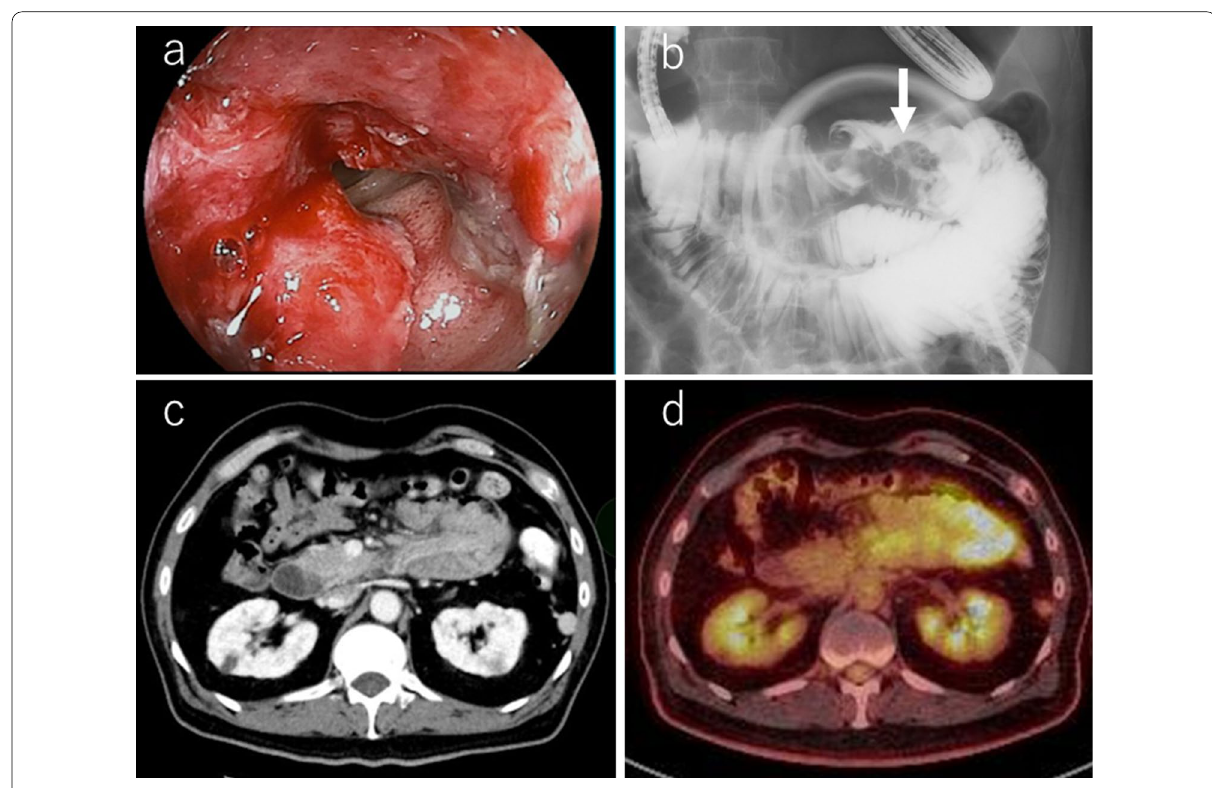
Fig. 1 Preoperative imaging findings. a Endoscopic findings: enteroscopy revealed an easily hemorrhagic tumor in the jejunum. b Findings of the small bowel series using meglumine sodium amidotrizoate: a tumor (white arrow) was found in the jejunum at the angle of Treitz. c Contrast-enhanced computed tomography findings: The tumor with intussusception appeared as a reniform shape (pseudokidney sign) longitudinally and demonstrated multilayered concentric rings of mass (target sign) transversely. A tumor with intussusception and regional lymph node swelling was located at the angle of Treitz. d Findings of the fluorodeoxyglucose positron emission tomography: this tumor had marked hypermetabolism, showing a standardized uptake value (SUV) max of 8.3, and the swollen regional lymph node showed mild hypermetabolism with a SUV max of